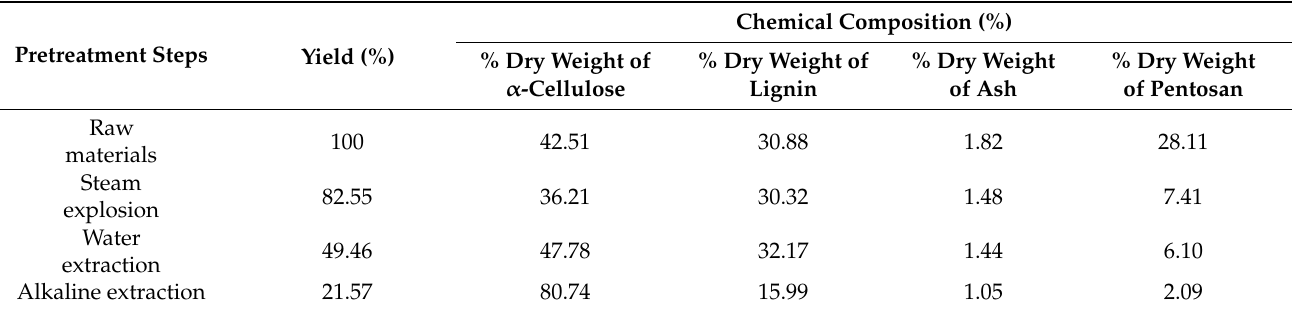
Table 6. Chemical compositions of oil palm fronds after the optimized condition of the alkaline pre- treatment.